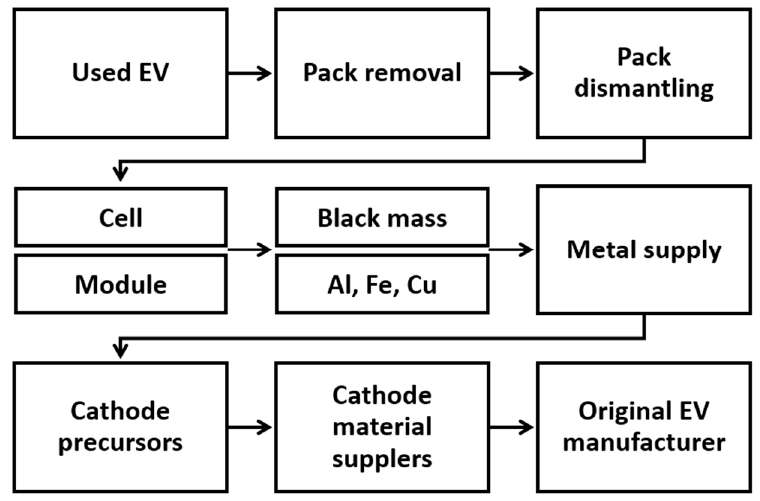
Figure 7. Lithium-ion battery recycling chain. Adapted from [34].